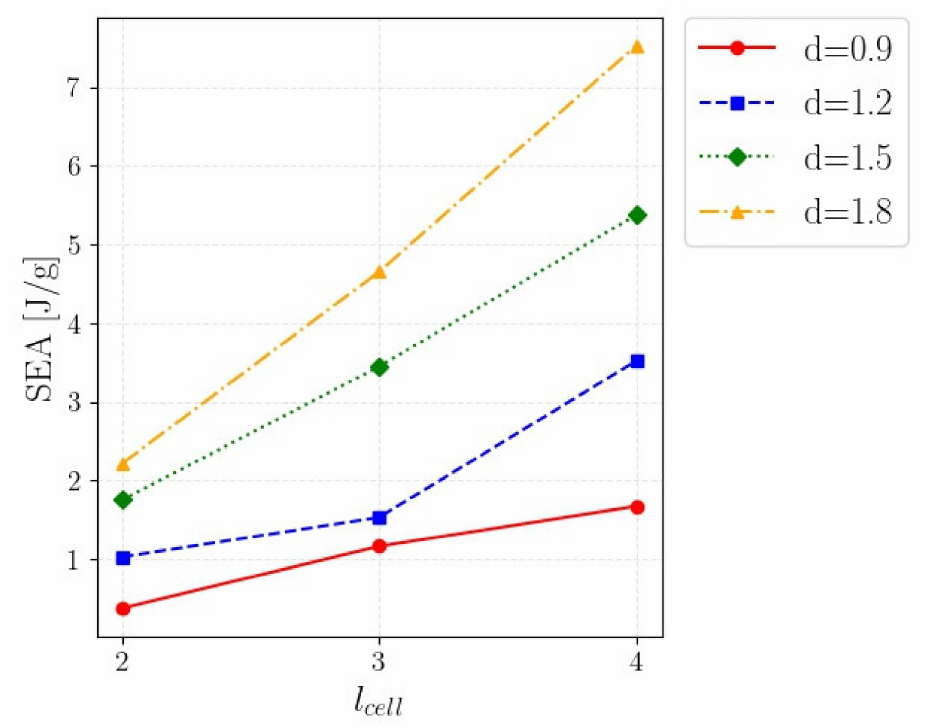
Figure 6. Interaction plot showing the average SEA with respect to the parameter l cell for the investigated d